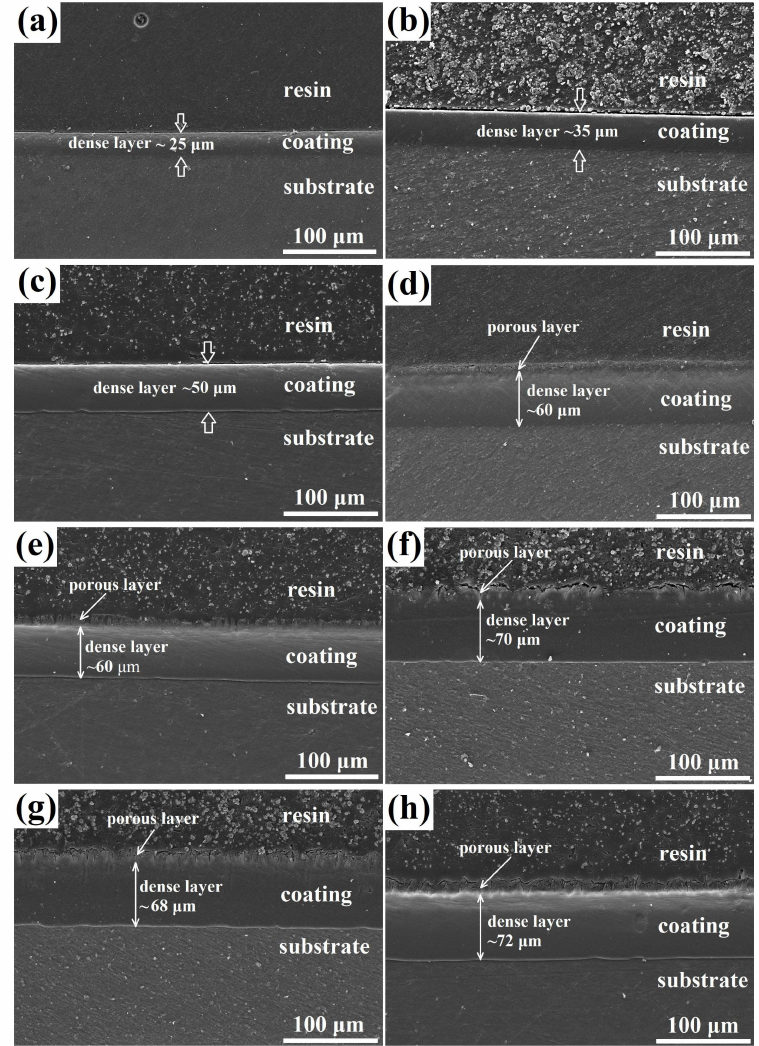
Figure 4. SEM cross-sectional morphologies of the coated samples with di ff erent anodizing durations: ( a , c , e , g ) are the cast-coated samples anodized for 10, 25, 30, and 40 min, respectively; ( b , d , f , h ) are the ECAP-coated samples anodized for 10, 25, 30 and 40 min,